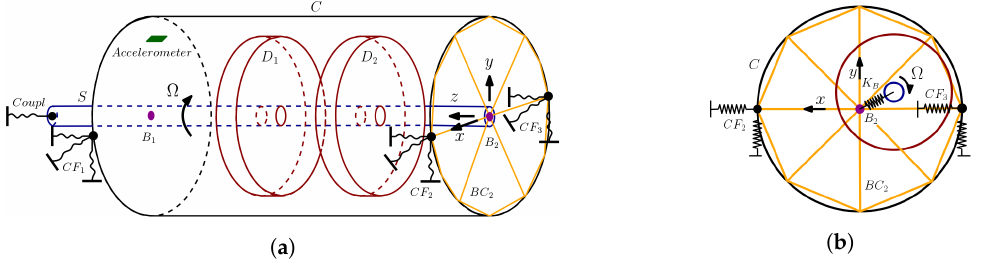
Figure 4. The rotor–flexible casing model: ( a ) perspective view; and ( b ) radial view of the model end, with the rotor displaced from the bearing node B 2 . K B represents bearing stiffness.